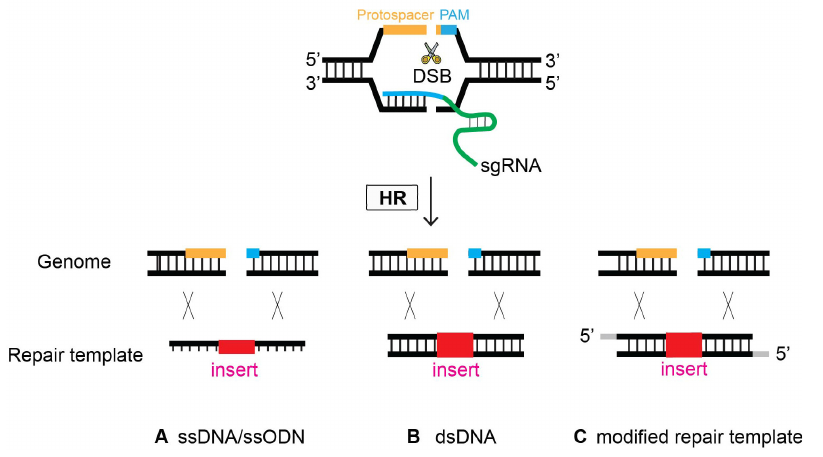
Figure 7. Oligonucleotides can serve as a template to repair DSBs via HR. At the site of CRISPR- Cas9-induced DSB, Single-stranded DNA (ssDNA), double-stranded DNA (dsDNA), and modified repair templates serve as a repair template. ( A ) ssDNA, ( B ) dsDNA, and ( C ) modified nucleotides as a repair template.